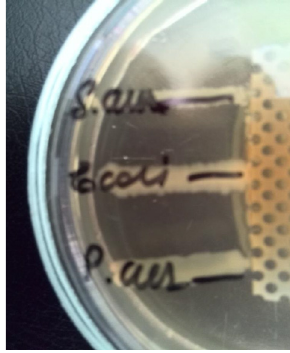
Fig. 2. The third day after seeding, microbial colonies grow near the titanium implant with the surface transformed into anatase after contamination, but are not fixed on the surface